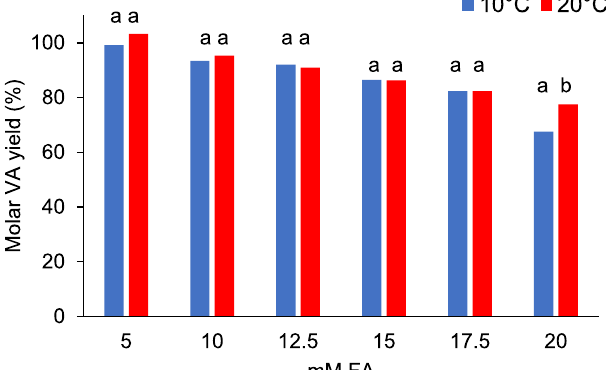
Fig. 4 Effect of temperature (10 °C and 20 °C) on VA production from various FA concentrations (10–20 mM) by P. aromaticivorans AR20-38. Data represent mean values of three replicates. Different letters ( a , b ) indicate statistically significant differences (LSD, P